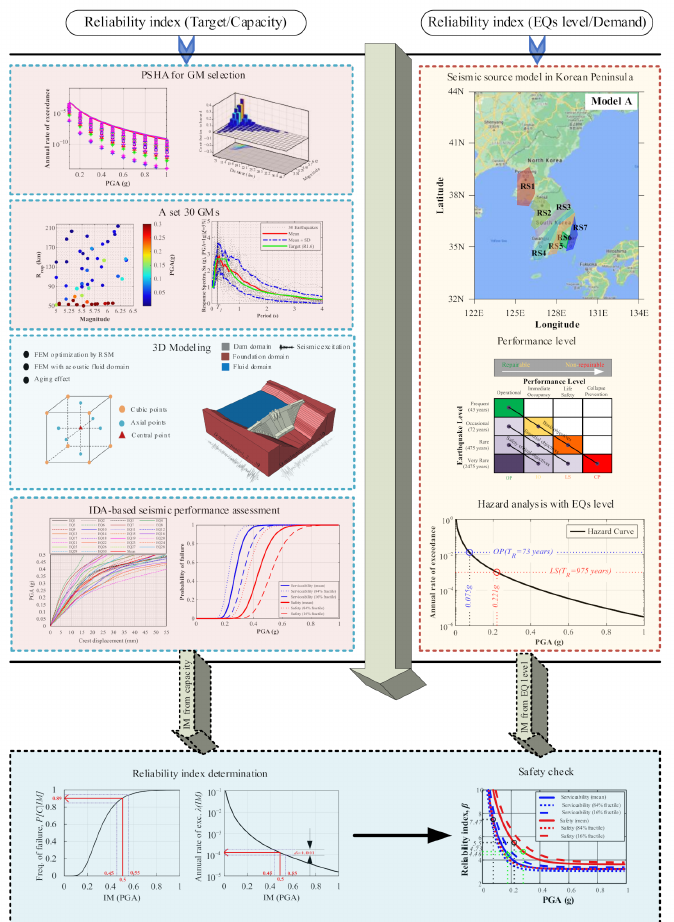
Figure 1. Flowchart of the safety index determination framework.